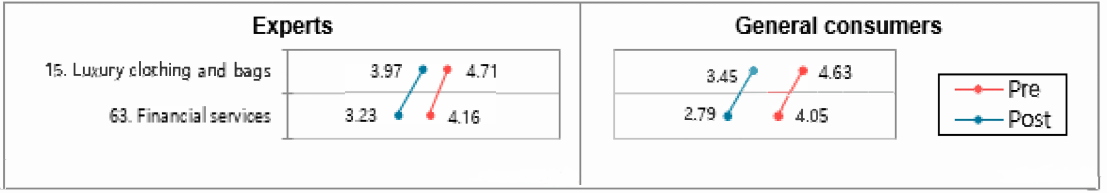
Figure 4. Items with significant t -test results in both experimental designs: quality inference.